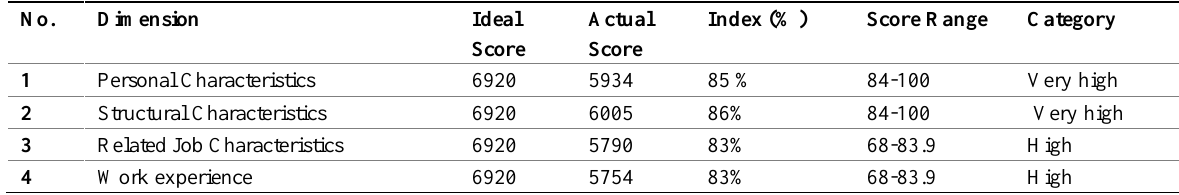
Table 11: Description of Affective Commitment